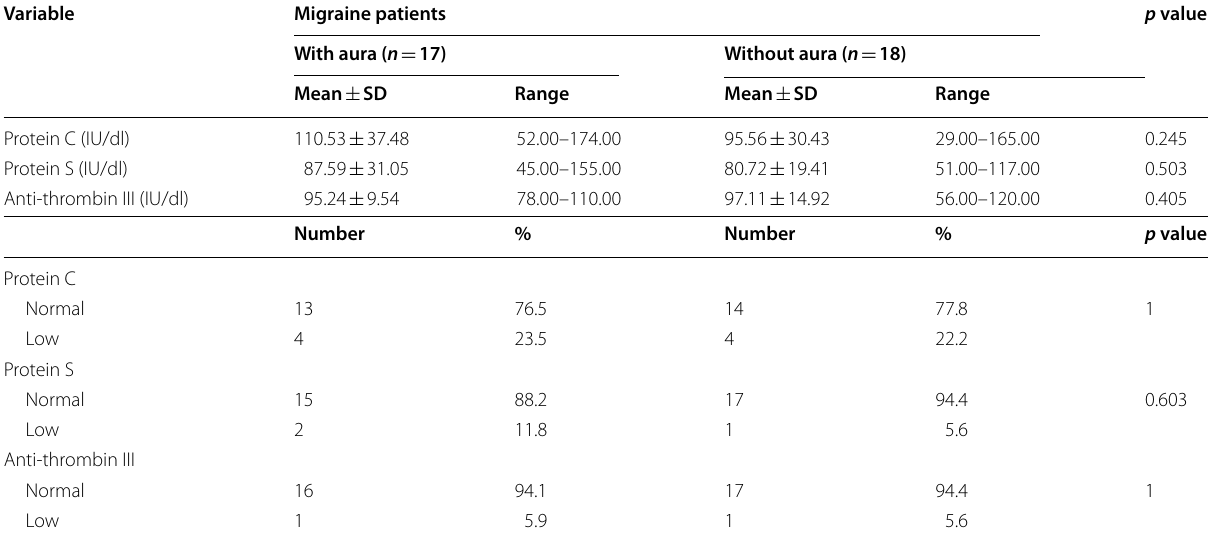
SD standard deviation; n